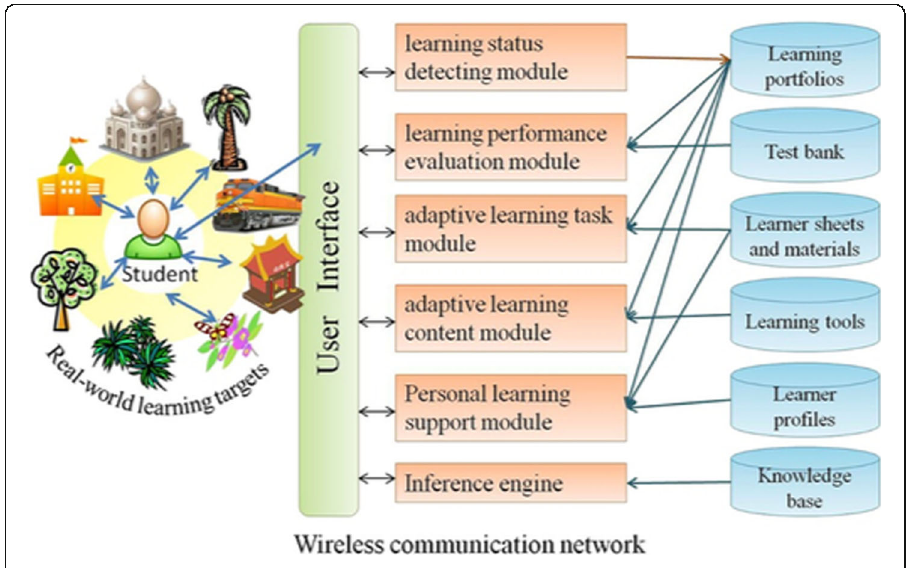
Fig. 3 Hwang ’ s framework of a SLE (Hwang, 2014)